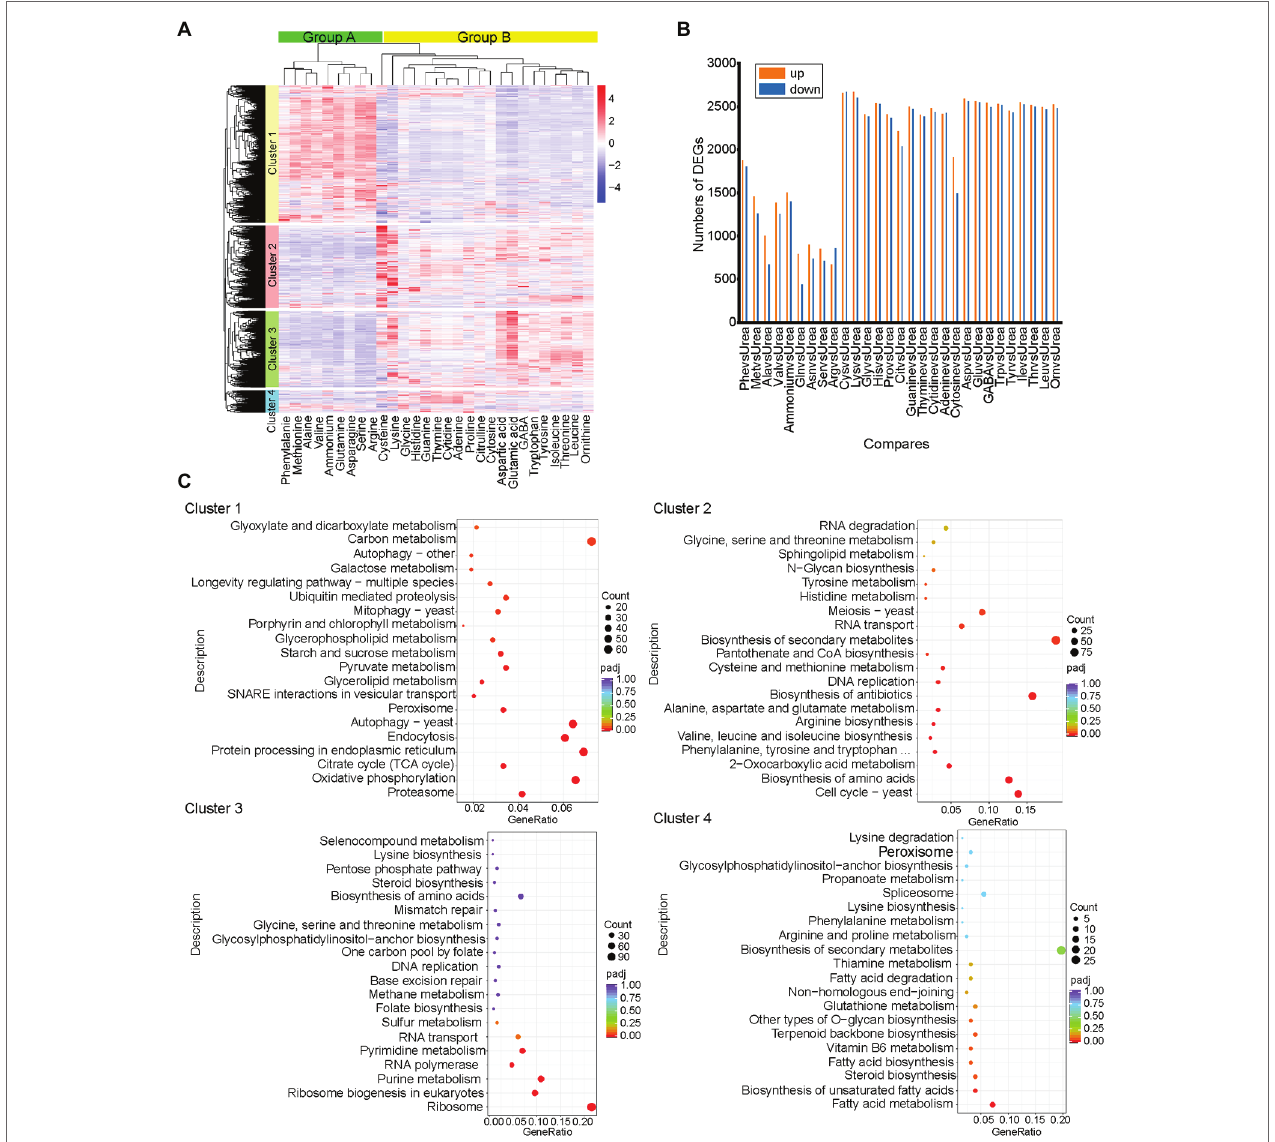
FIGURE 1 | Overview of RNA-Seq data. (A) Clustering heatmap of all differentially expressed genes. Genes with similar transcription patterns were clustered into a cluster, resulting in four clusters. Samples were clustered to two groups. The thermogram shows the transcription of genes in different samples. The colors of squares represent values after normalization. Downregulated genes are highlighted in blue, and upregulated genes are highlighted in red. (B) Number of differentially expressed genes in each comparison group. Urea served as a control. Genes with an adjusted value of p <0.05 and |log 2 foldchange| >0.0 were considered differentially expressed. (C) KEGG analysis of the four clusters. KEGG pathway enrichment used padj <0.05 served as threshold criteria for significant enrichment. The 20 KEGG pathways with the most significant enrichment are shown in the scatter